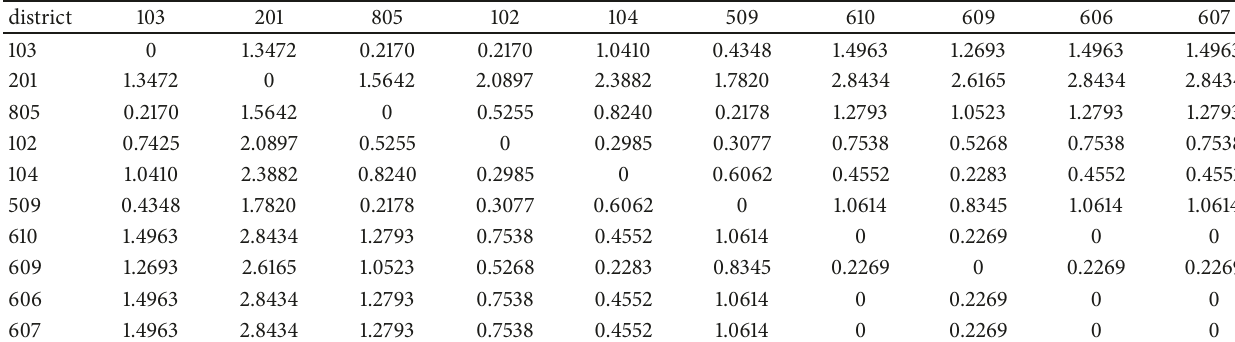
Table 3: The distance matrix of the ten most extreme districts for the female sex in 2015.